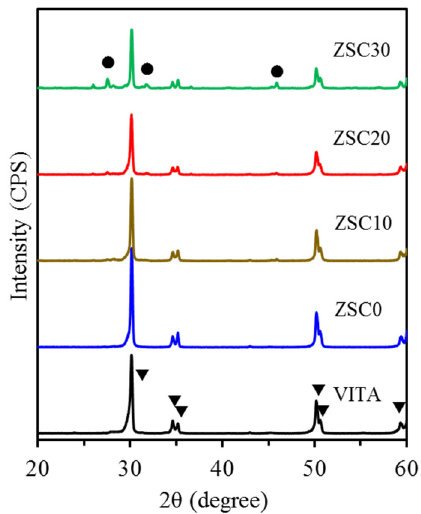
Figure 1. XRD patterns of all core materials after oxygen plasma treatment: ▼ : ZrO 2 ; ● : CaZrO 3 or Ca 3 ZrSi 2 O 9 .